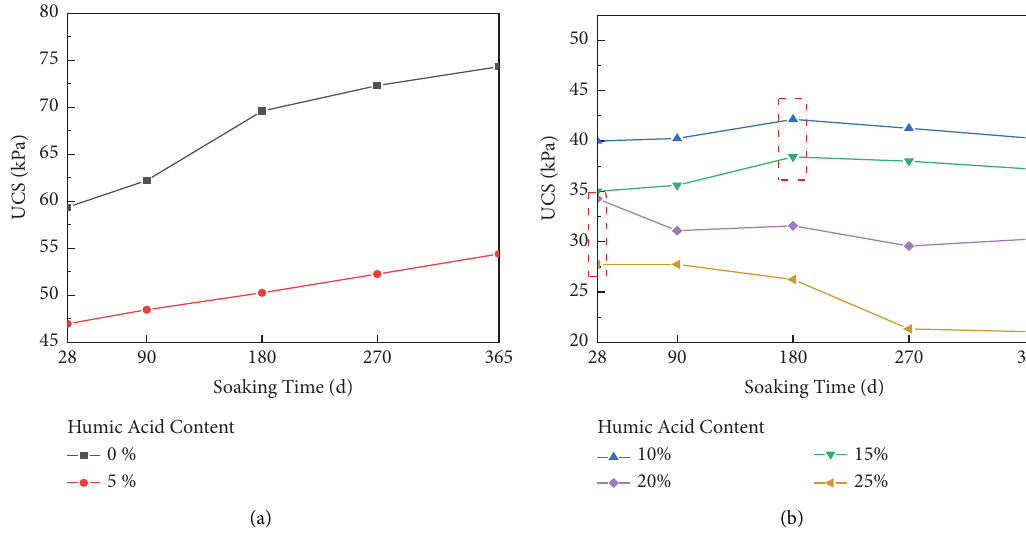
Figure 8: Relationship curve between sample UCS and soaking age (pH value of FA solution: 6.0).